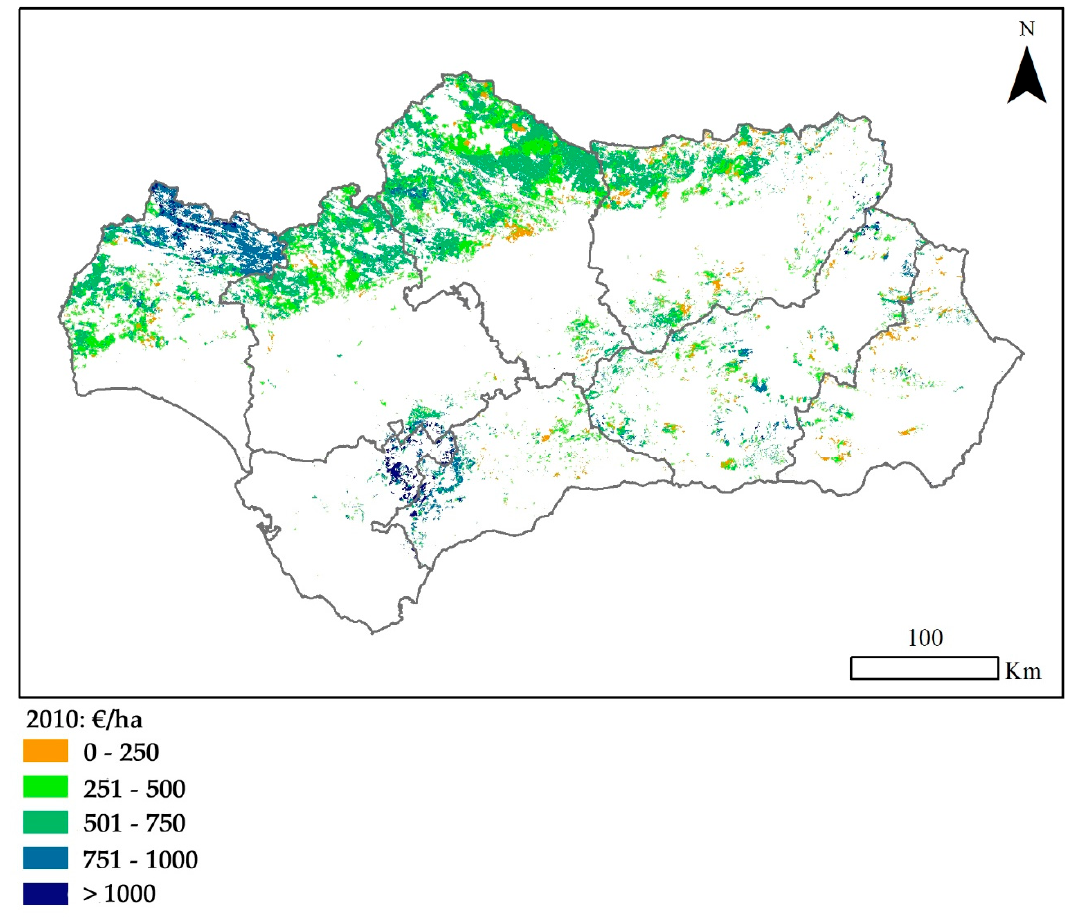
Figure 2. Map of total ecosystem services at producer prices measured by the simplified Agroforestry Accounting System in Andalusian holm oak open woodlands (2010: €/ha). Source: Eloy Almazán based on [8,41]. Andalusian holm oak woodland surface: 1,408,170 hectares.